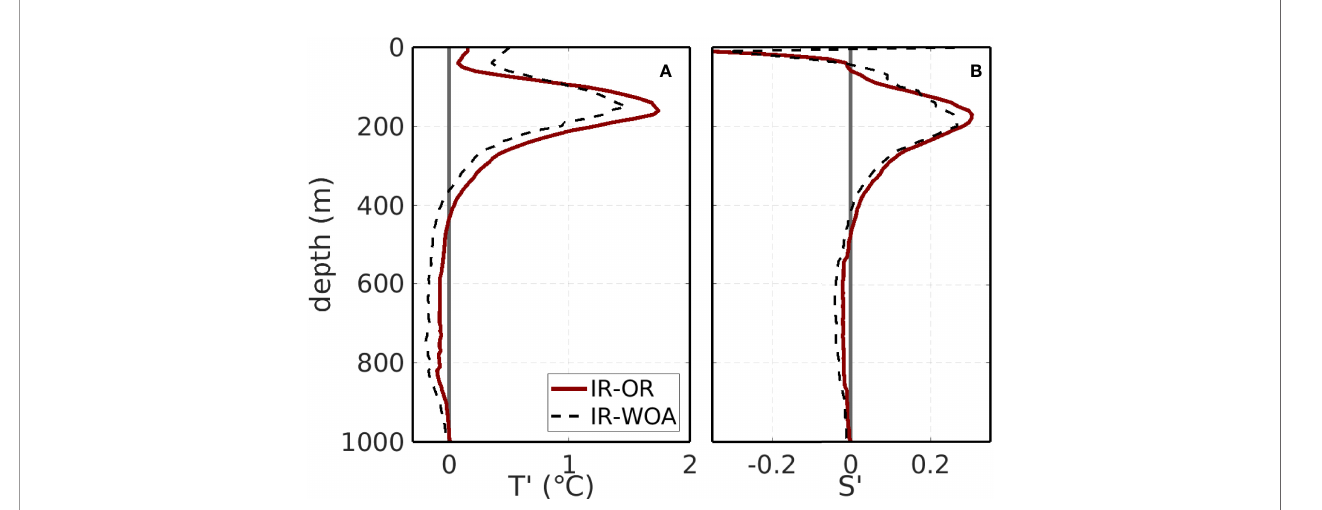
FIGURE 7 | Total mean T (A) and S (B) NBC ring anomalies with respect to the OR mean pro fi le from EN4.2.0 (solid red line) and to the WOA13 climatology (dashed black